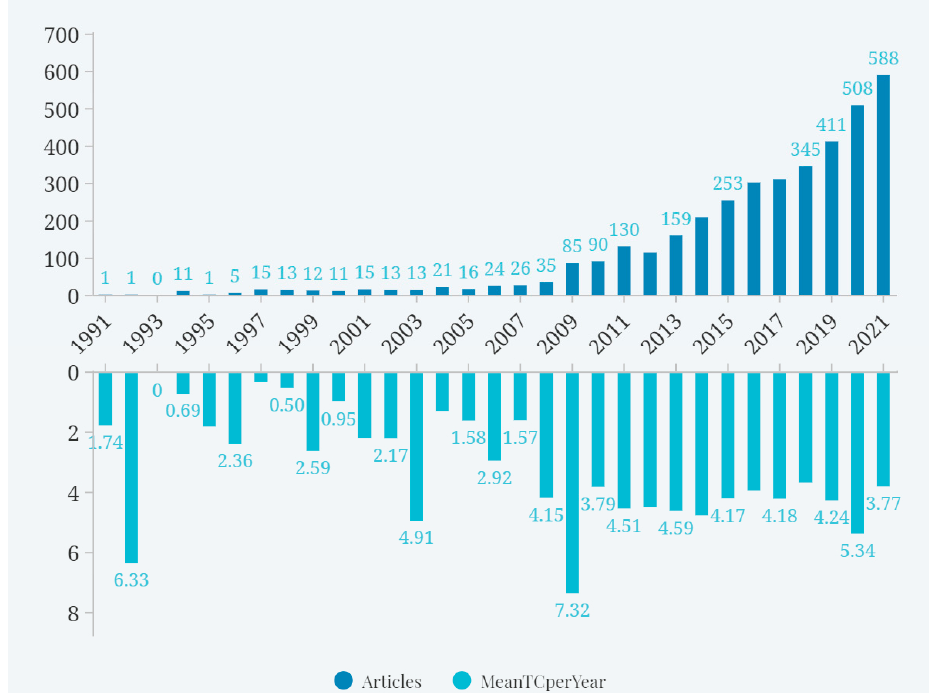
Figure 2. Number of published and cited food security research articles from 1991 to 2021.